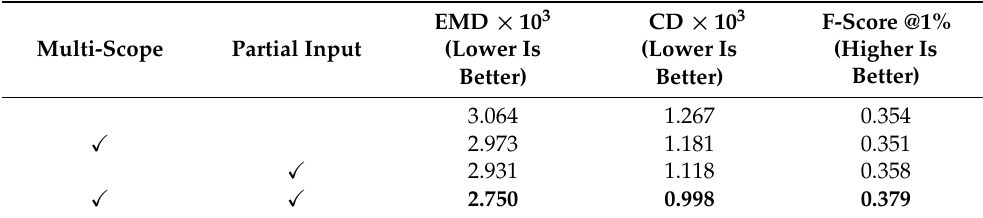
Table 7. Ablation study on partial input in decoder and multi-scope in the encoder using IntrACom- pletion dataset.